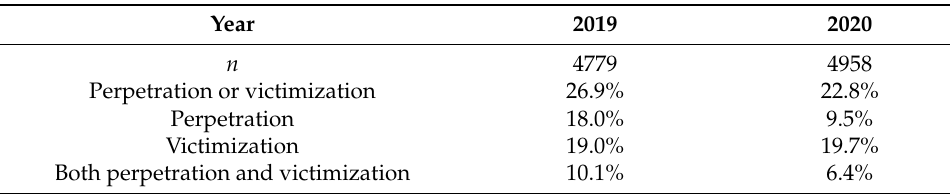
Table 3. Comparison in experience rate of